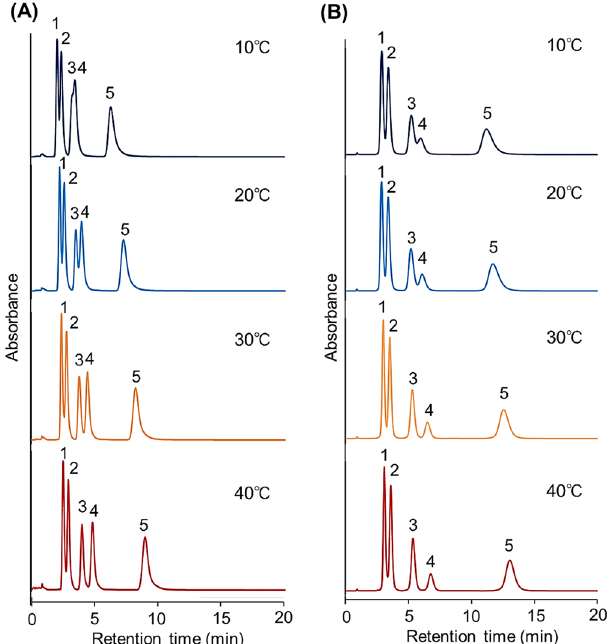
Figure 3. Chromatograms of hydrophobic steroids using crosslinked PNIPAAm modified-bead packed columns using beads prepared via polymerization for ( A ) 5 h, and ( B ) 18 h. The mobile phase was pure water. The flow rate of the mobile phase was 1.0 mL/min. Detection at 254 nm. Peak 1 = hydrocortisone, peak 2 = prednisolone, peak 3 = dexamethasone, peak 4 = hydrocortisone acetate, and peak 5 =